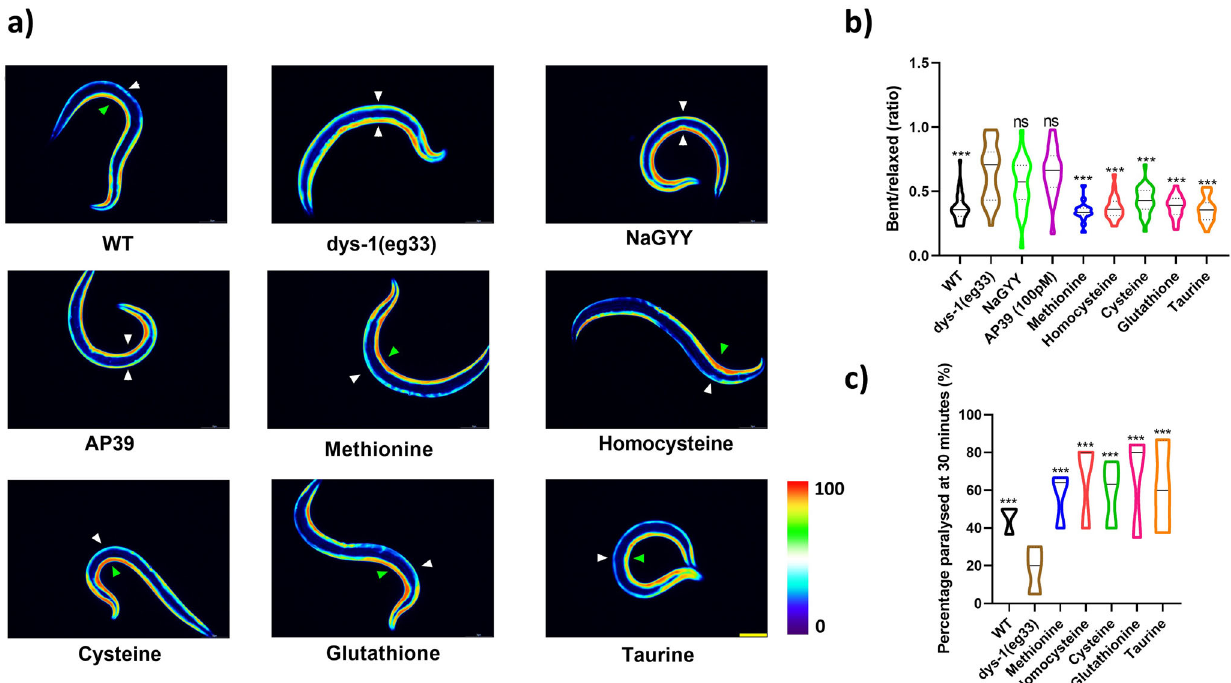
Fig. 7 Calcium mishandling is improved in the dys-1(eg33) animals treated with SAA. a Representative images of calcium report strain in HBR4 ( wt ), HBR4xBZ33 ( dys-1(eg33 )) and HBR4xBZ33 treated with H 2 S and SAA: L-methionine (10 mM), L-homocysteine (10 µ M), L-cysteine (10 µ M),